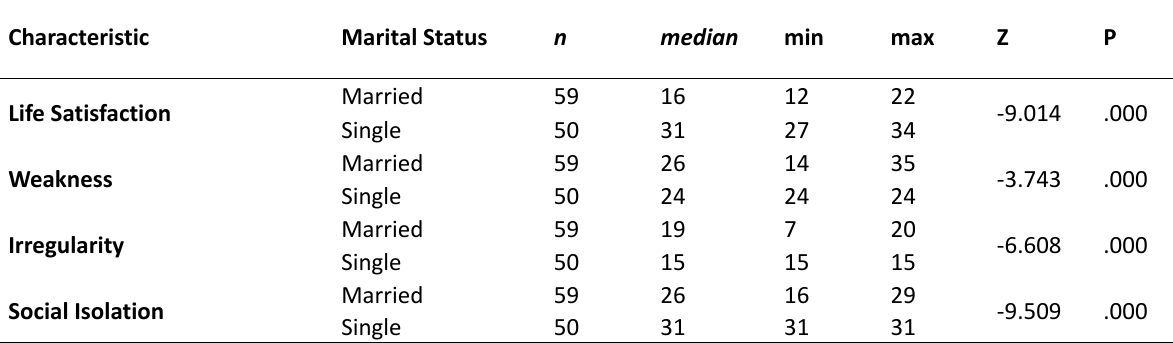
Social Isolation